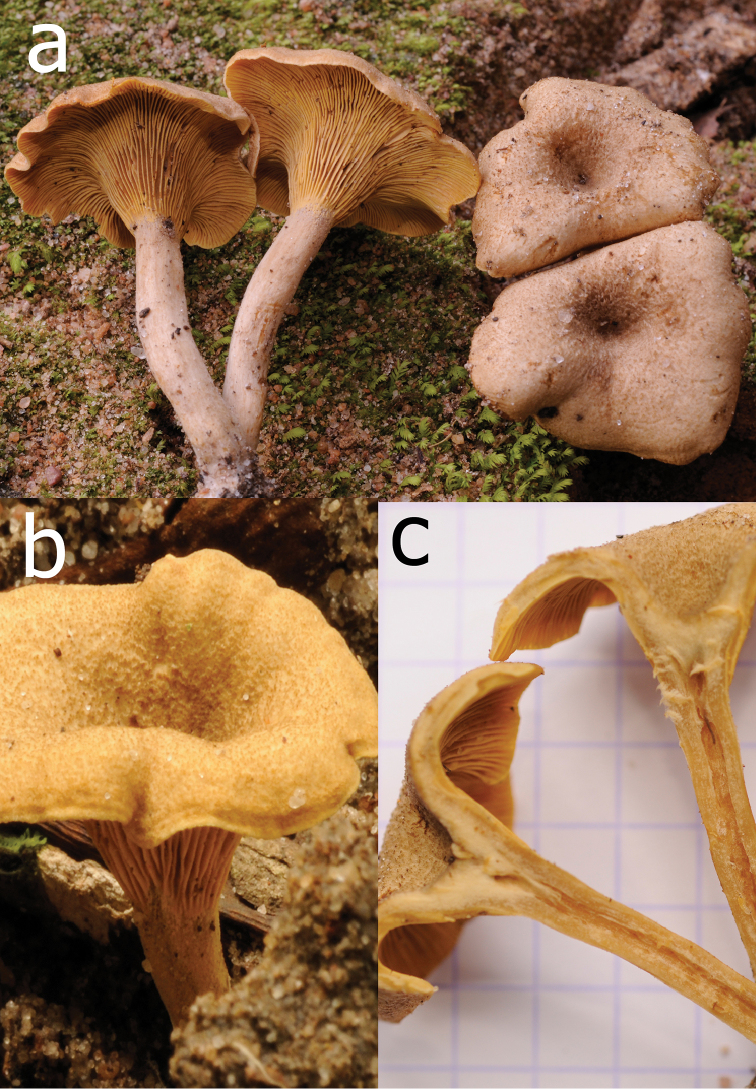
Cantharellustomentosoides (holotypus, Buyck 16.007). a Field habit b detail of the pileus surface c Longitudinal section showing the fistulose stipe. Photos: B. Buyck.